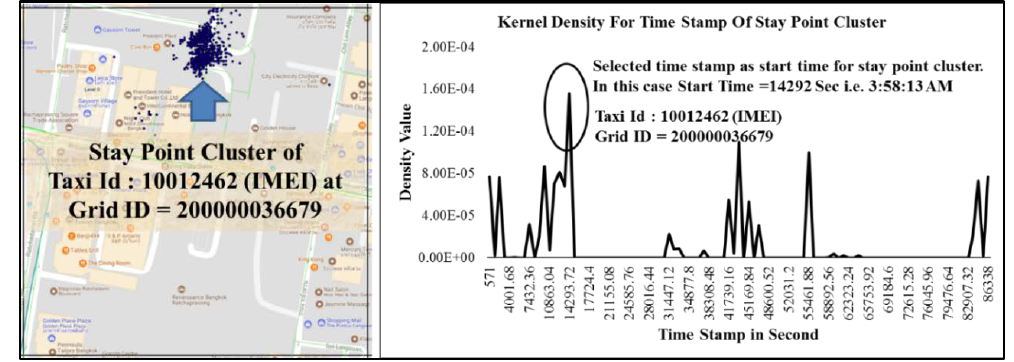
Figure 6. Left : Stay point cluster; Right : Kernel density function of timestamp.